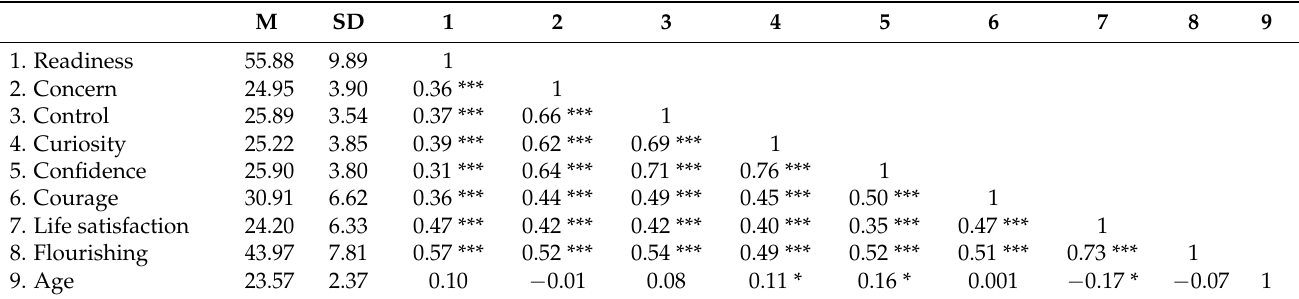
Table 1. Descriptive statistics and correlations between the dimensions of the study (Pearson’s